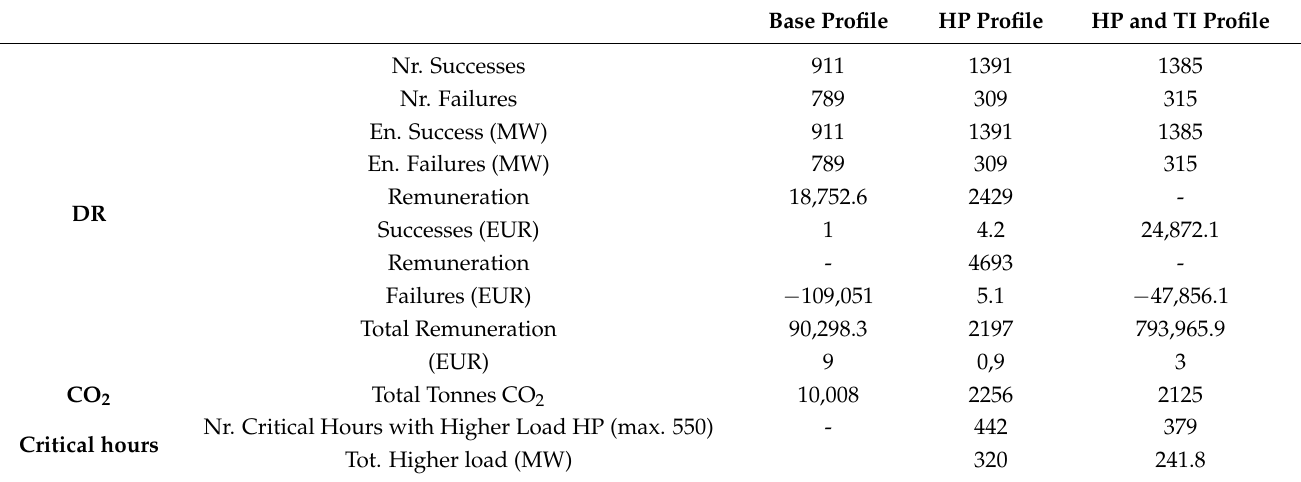
Table 2. Average profile comparison.